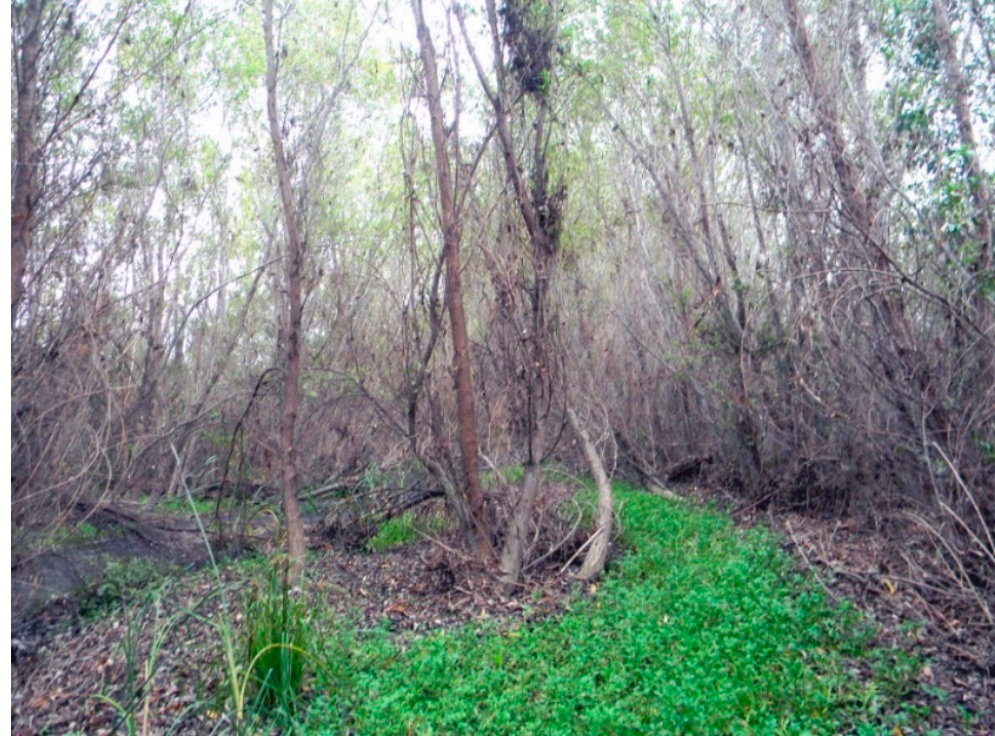
Figure 3. Stand of native vegetation containing S. laevigata at study site S2.